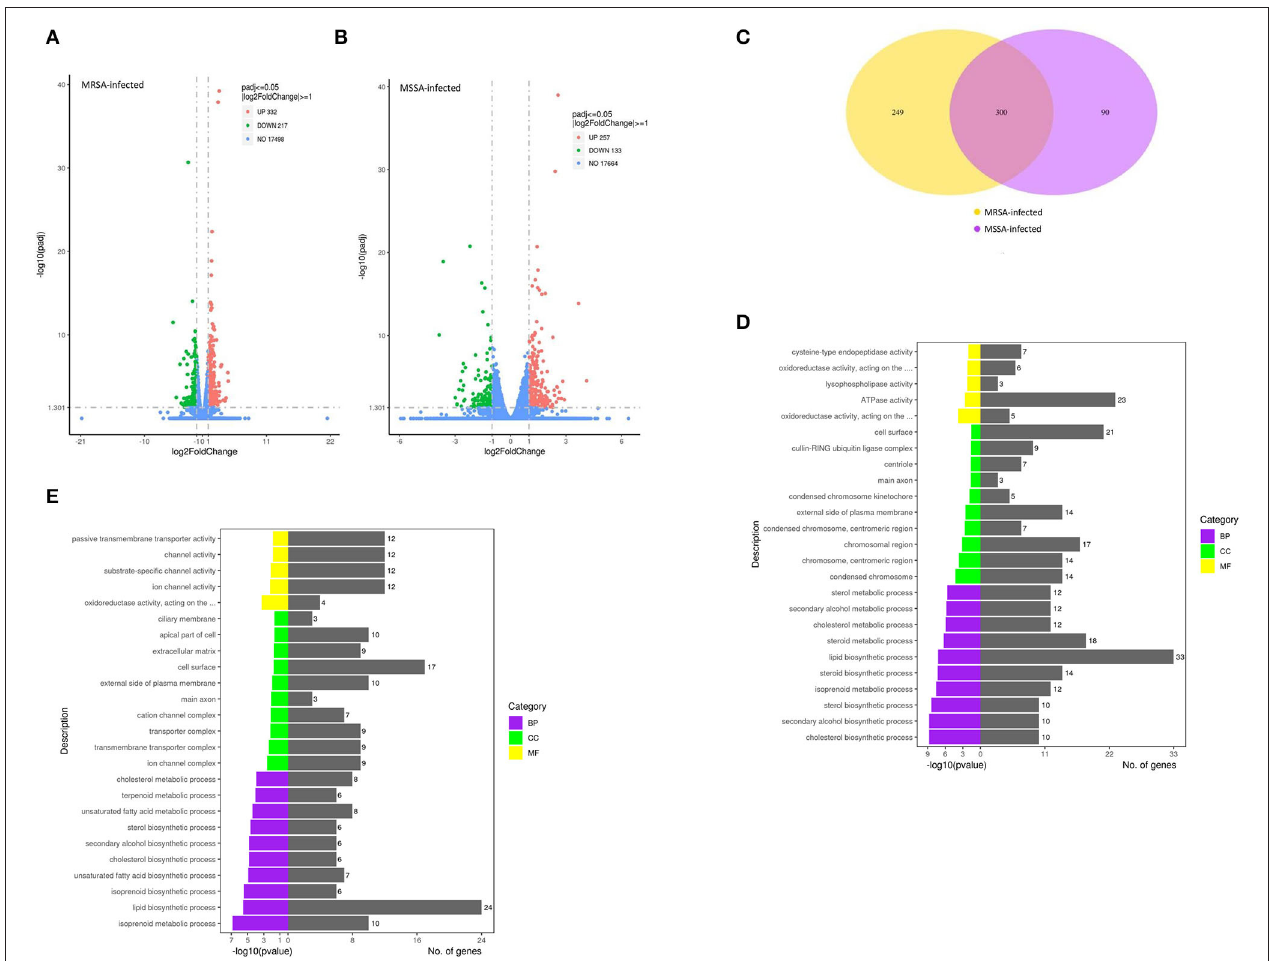
FIGURE 3 | The functional enrichment analysis of total DEGs. (A) and (B) The volcano plots of total differentially expressed genes of MRSA-infected and MSSA-infected MAC-T cells. Log 2 |Fold change| > 1 and p < 0.05 are the thresholds. Red plots represent up-regulated DEGs and green plots represent down-regulated DEGs. (C) The Venn diagram of total differentially expressed genes. Purple represents MRSA-infected group. Yellow represents MSSA-infected group. (D) and (E) The GO functional enrichment pathway of MRSA-infected and MSSA-infected MAC-T cells.